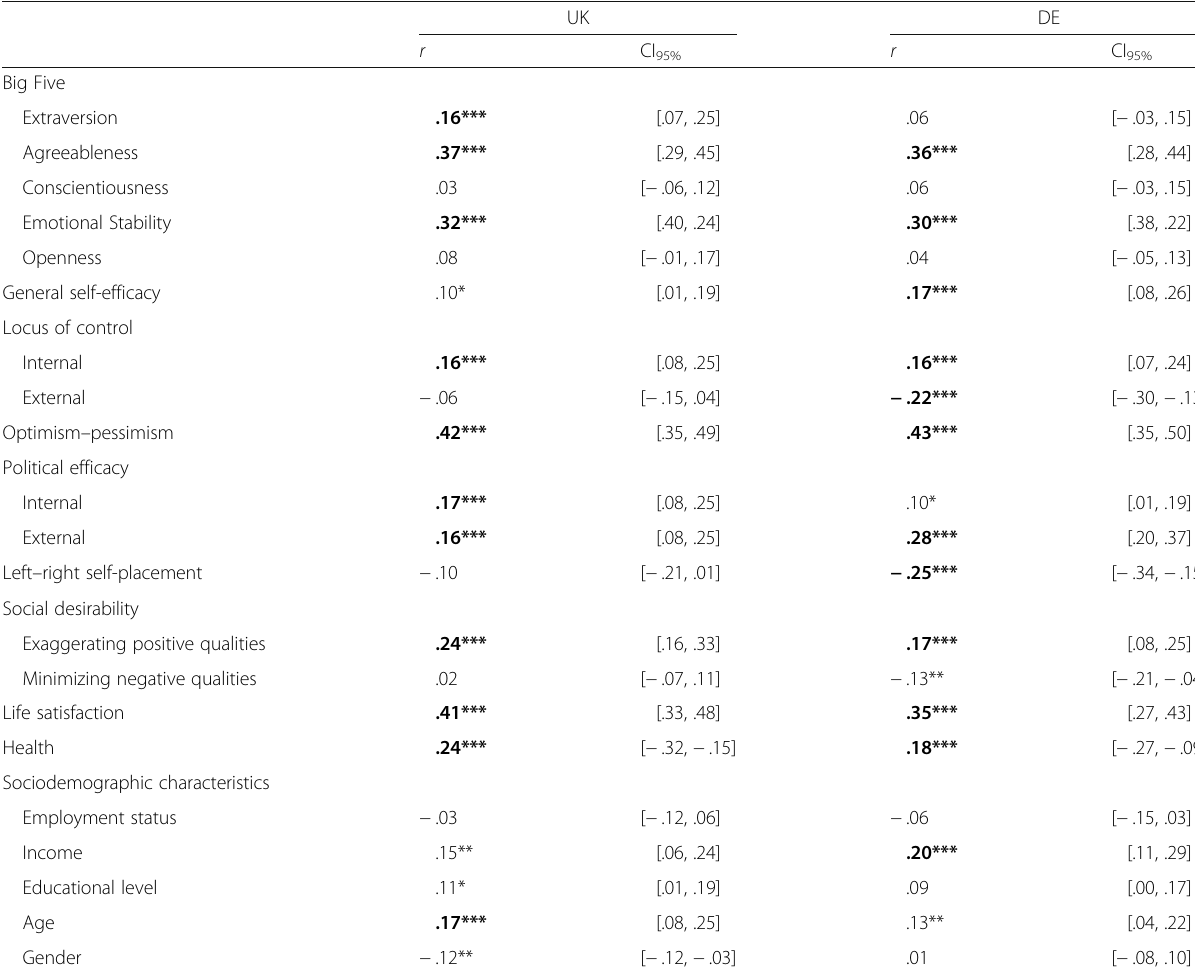
Table 4 Correlations of KUSIV3 with relevant